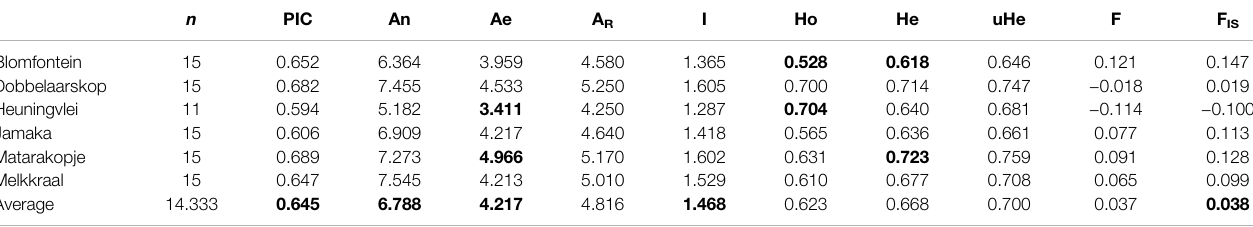
TABLE 6 | Genetic diversity indices for six wild Aspalathus linearis populations based on 11 microsatellite loci. n — sample size; PIC — Polymorphic Information Content; An — mean number of alleles per locus; Ae — mean number of effective alleles; A R — allelic richness; I — Shannon ’ s index; Ho — observed heterozygosity; He — expected heterozygosity; uHe — unbiased expected heterozygosity; F — fi xation index; F IS — inbreeding coef fi cient. n PIC An Ae A R I Ho He uHe F F IS